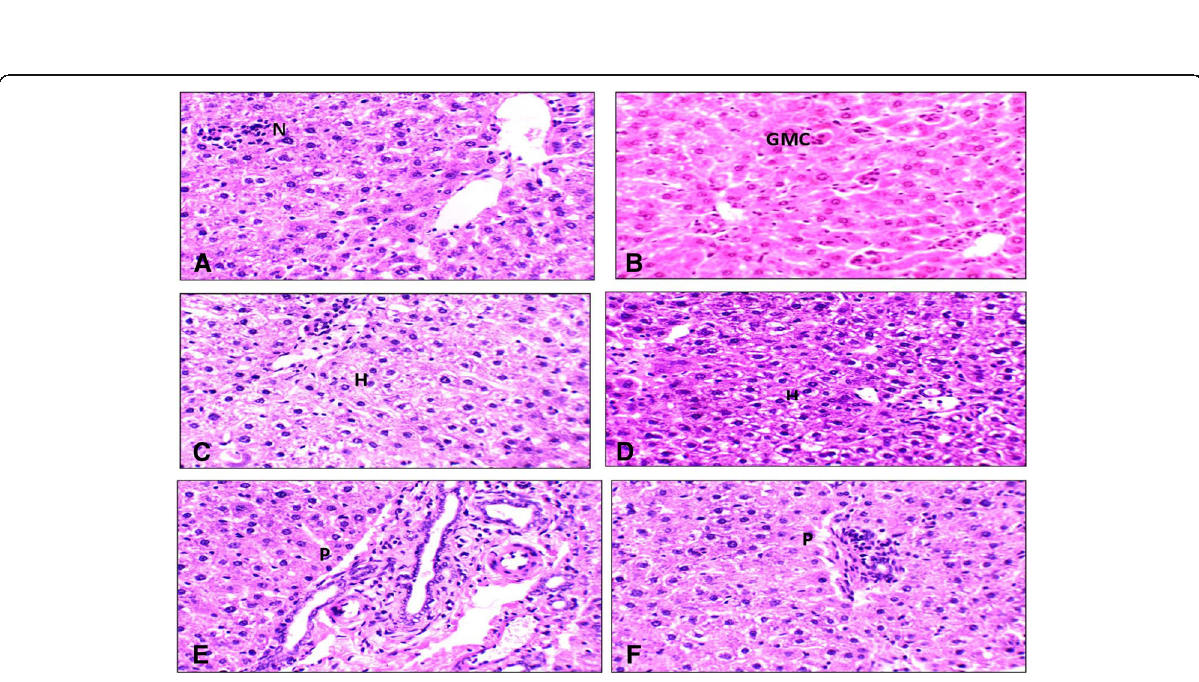
Fig. 2 a Section of liver from a rat treated with 500 mg/kg body weight COC for 90 days showing congestion of central vein (CV) and cytoplasmic vacuolization of the hepatocytes (arrows), ×400. b Liver section obtained from a rat treated with 500 mg/kg COC; the restoration of the normal arrangement of the hepatocytes and giant multinucleate cells (GMC). c Section of liver from a rat treated with 1000 mg/kg body weight COC for 90 days showing hydrobic degeneration (H) appeared as cytoplasmic vacuolization of the hepatocytes and increase of pyknotic cells. d Section of liver from a rat treated with 1000 mg/kg body weight COC and curcumin for 3 months showing hydrobic degeneration (H) appeared as cytoplasmic vacuolization of the hepatocytes and absence of pyknotic cells. e Liver section of a rat examined after 90 days of treatment with 2000 mg/kg body weight COC shows a large mass of inflammatory infiltration in the portal area (P). f Liver section obtained from a rat treated with 2000 mg/kg body weight COC followed with curcumin extract for 90 days showing improvement of hepatic tissue and decreasing the mass of inflammatory infiltration in the portal area (P), H&E,